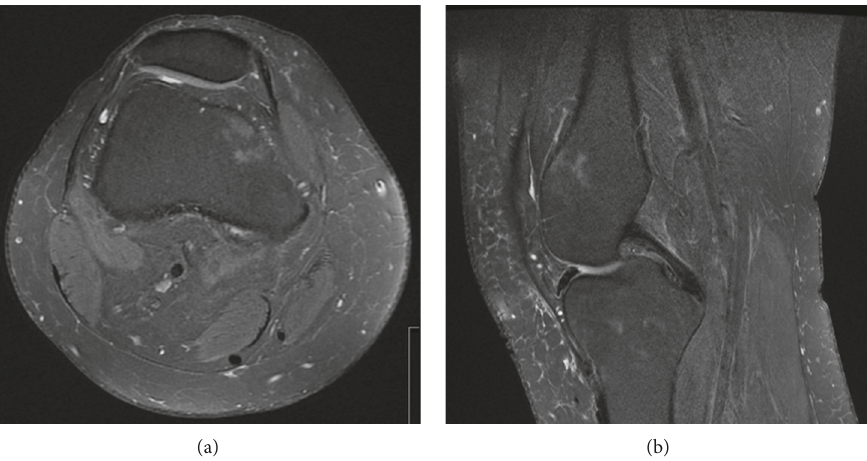
Figure 4: MRI (T2 Fat Sat; (a) axial and (b) sagittal images of left knee) showing medial femoral condyle marrow